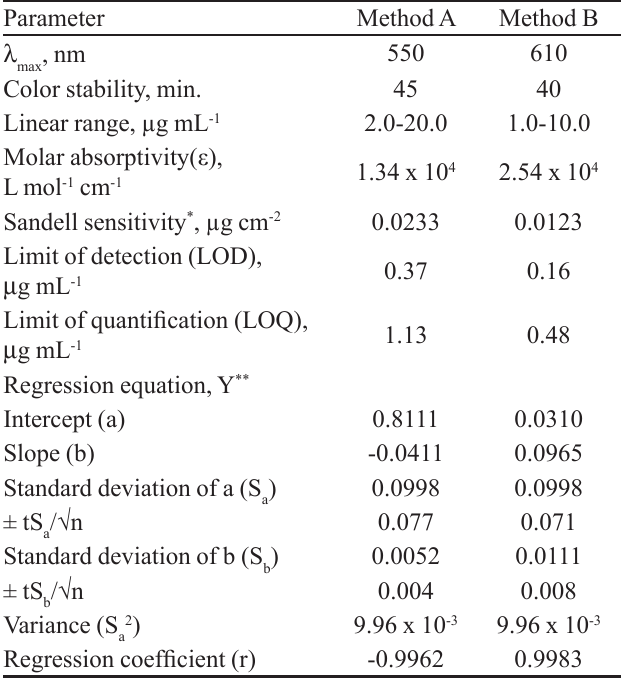
TABLE II - Sensitivity and regression parameters